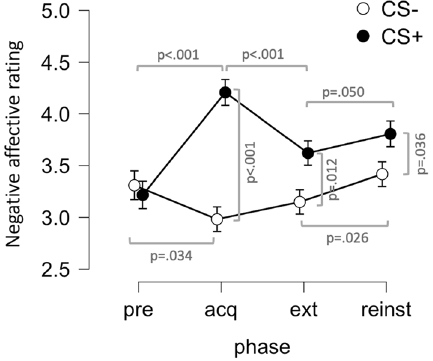
Figure 2. Affective ratings to conditioned stimuli (CS). Negative affective ratings were similar for stimuli paired with aversive outcome (CS +) and stimuli never paired with aversive outcome (CS−) pre acquisition, but differed after acquisition (acq), with increased negative ratings of CS+ and reduced negative ratings of CS−. Post extinction (ext), ratings of CS+ and CS− still differed, but to a lesser degree, whereas reinstatement (reinst) increased negative ratings of both CS. Affective ratings is a composite score consisting of the mean rating (1[not at all] to 7[totally]) of how much participants agree with feeling fear, discomfort, irritation and calm (reversed score). Points and error-bars indicate means and